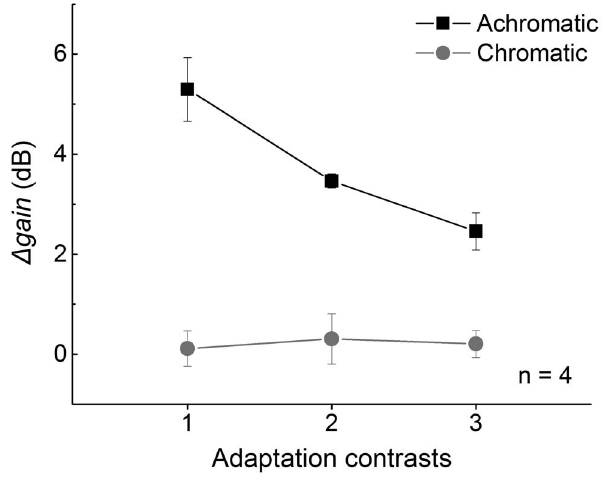
Figure 4. Average D gain across participants. The same tendency as that in Figure 3 is illustrated (achromatic condition, black square; chromatic condition, gray circle). Error bar shows the standard error of